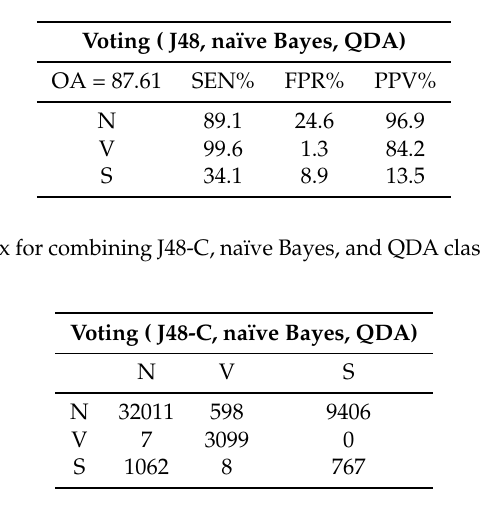
Table 21. Performance measures for combining J48, naïve Bayes, and QDA classifiers using Voting scheme (N,S,V).